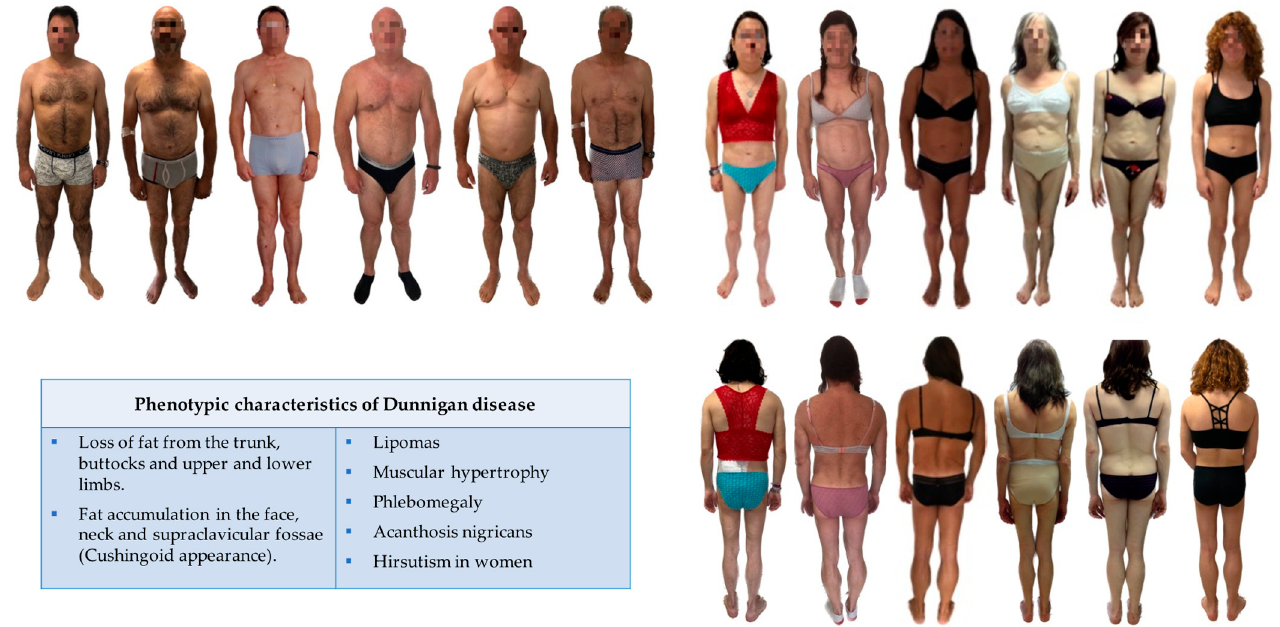
Figure 3. Clinical features of Dunnigan disease. While there is a loss of adipose tissue from the trunk, buttocks and limbs, fat excess in the face and neck and muscle hypertrophy is evident in women with FPLD2; in men, this characteristic phenotype is not so apparent.